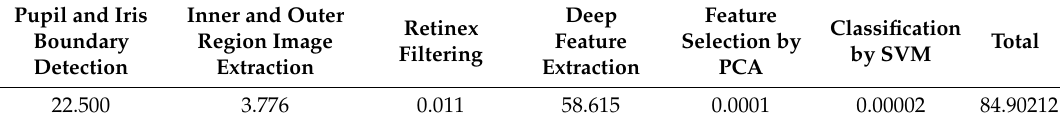
Table 13. The processing time of our proposed iPAD method (unit: ms).